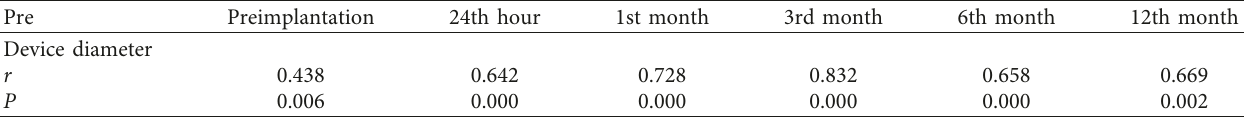
Table 2: The correlation coefficient ( r ) and probability ( P ) values between device diameter and serum nickel levels.